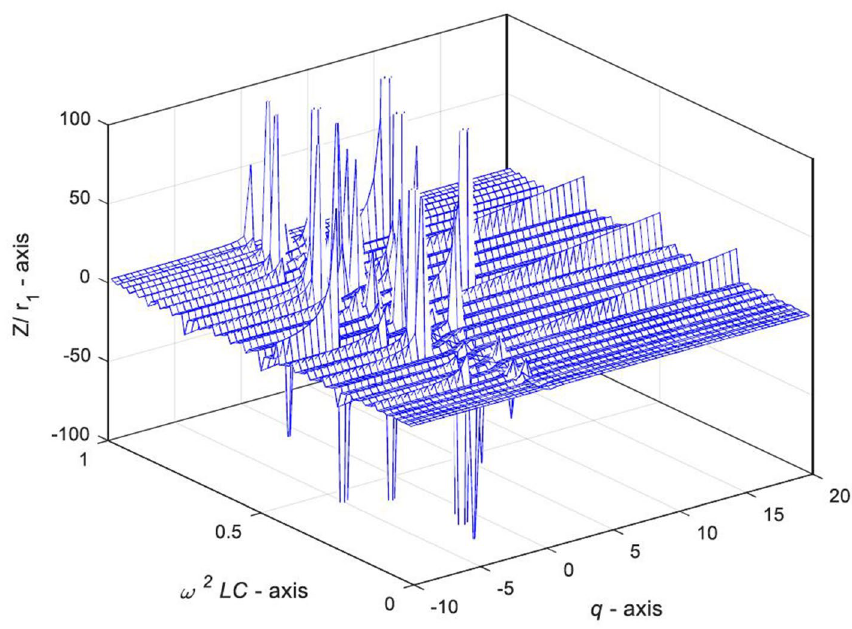
ω 2 LC and q , in case of